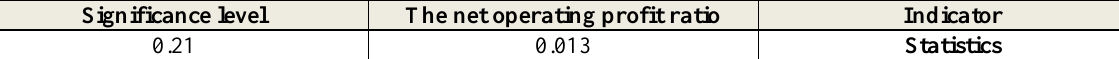
Table 3. Kolmogorov-Smirnov test after normalization process.